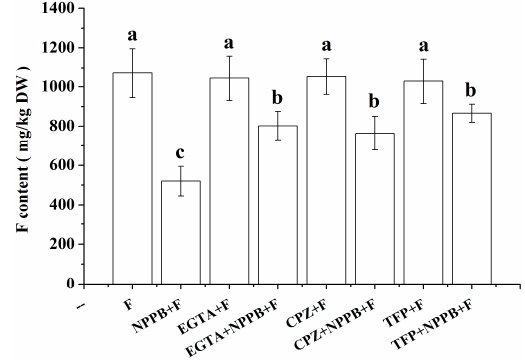
Figure 6. Effect of EGTA, CPZ and TFP pre-treatment on relative F accumulation in NPPB-treated tea plants. NPPB + F indicates tea roots were applied with 50 µM NPPB for 12 h and then followed with 10.5 mM F for 1 day; EGTA + F, CPZ + F, and TFP + F indicate that 6 h pretreament with 1 mM EGTA, 50 µM CPZ and 50 µM TFP and then treated with F treatment; EGTA + NPPB + F, CPZ + NPPB + F, and TFP + NPPB + F indicate that 6 h pretreament with 1 mM EGTA, 50 µM CPZ and 50 µM TFP were applied to the tea roots under NPPB + F treatment, respectively. Data indicate mean ± SD ( n = 4). The error bars indicate difference among the treatments and different low case numbers near the chart bars indicate the level of significant difference compared with control at p < 0.05.